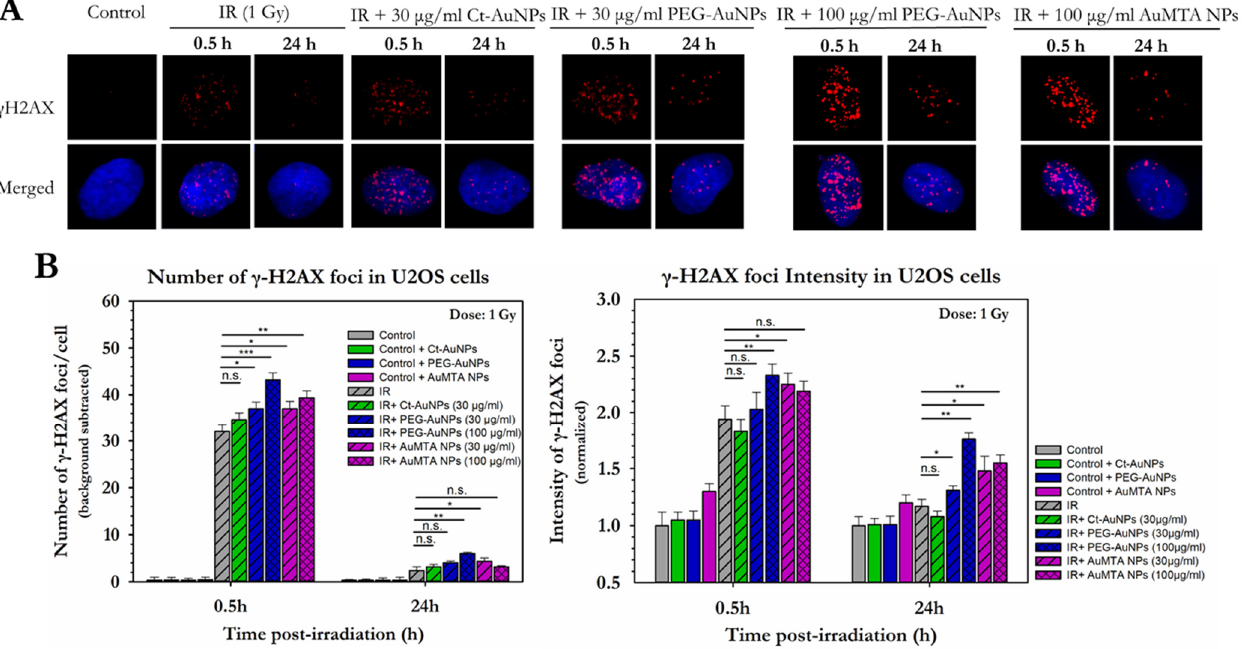
Figure 10. Quantitative and qualitative representation of DSBs in U2OS cells, after AuNP-induced radiosensitization with 1 Gy 320 KVp X-rays. ( A ) The nucleus is stained with DAPI, shown in blue, and the marker for DNA DSBs ( γ H2AX) is shown in red. ( B ) Figures show the average number of γ H2AX foci as well as the normalized foci intensity counted 0.5 h and 24 h after exposure. Statistical significance was determined using Student t test: * p ≤ 0.05, ** p ≤ 0.01, *** p ≤ 0.001, n.s.: not signifi- cant.